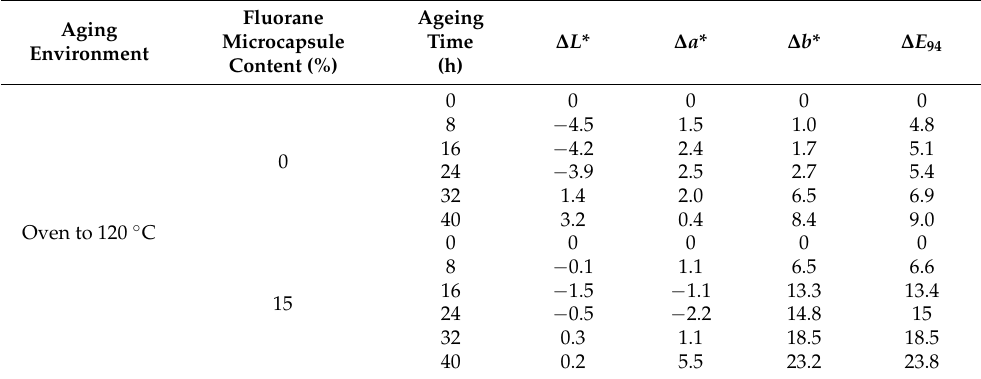
Table 10. Effect of aging time on the color difference of the topcoat. Aging